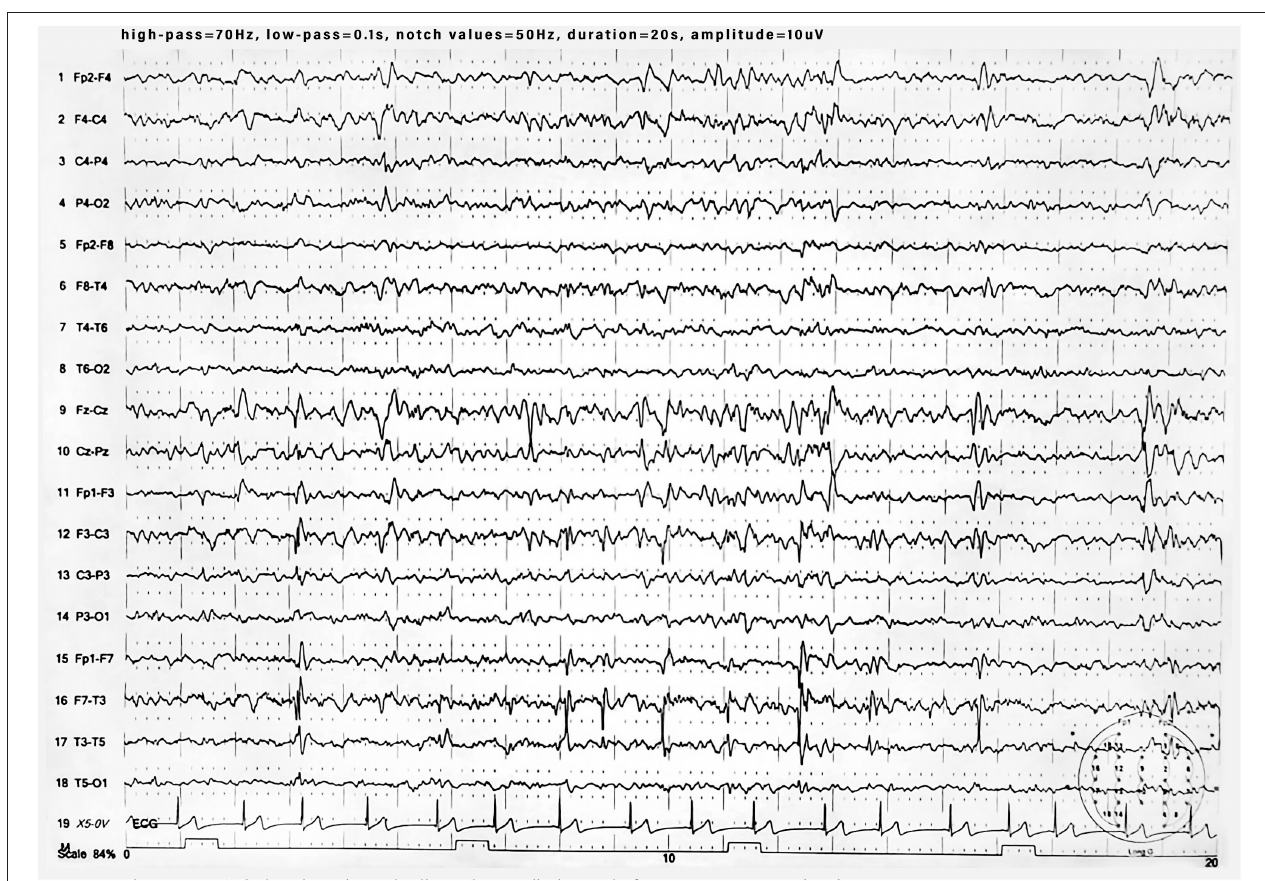
FIGURE 2 | EEG during sleep showing spike and wave discharges in fronto-centro-temporal